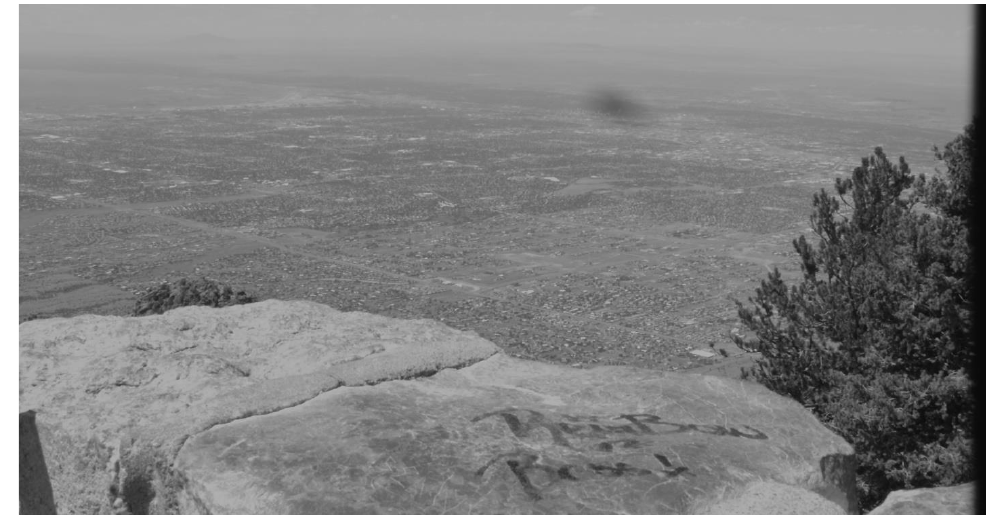
Figure 2. Video Frame captured from the Peak of Sandia Mountain.